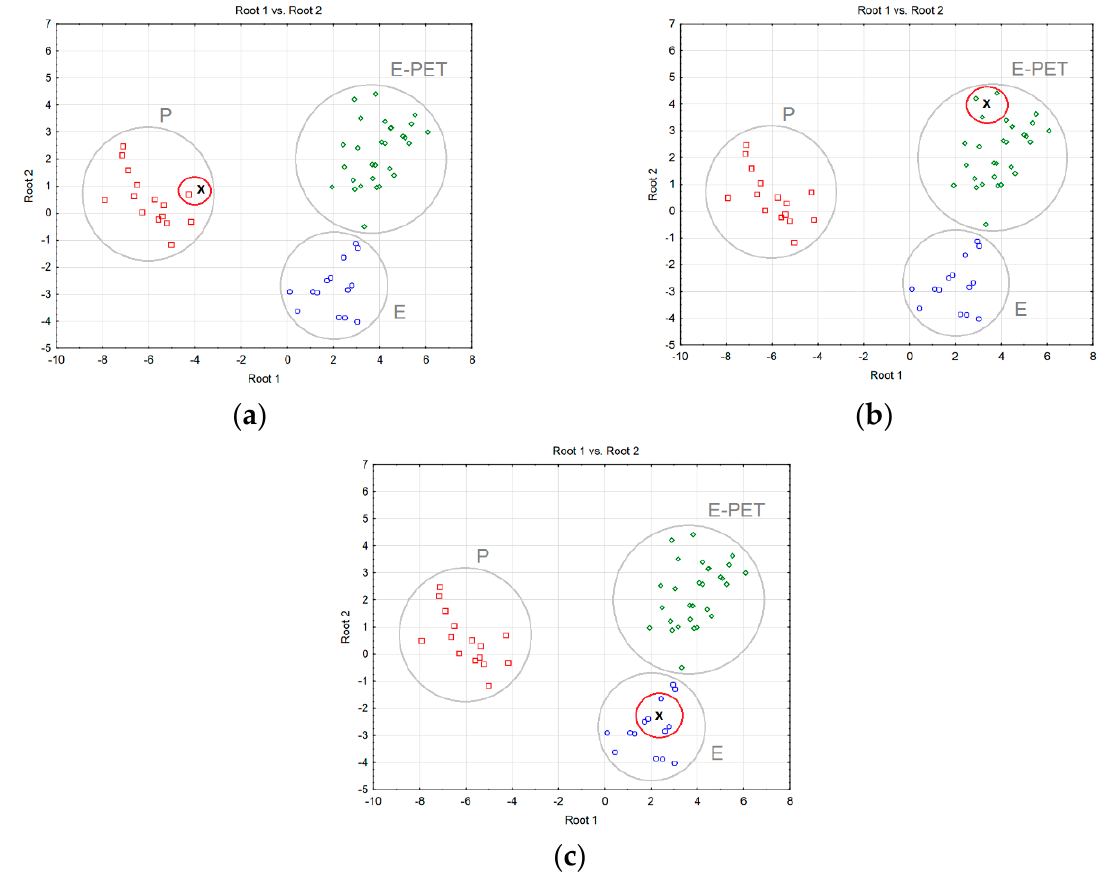
Figure 8. Selection of the mortar composition using the nearest-neighbor method using data from: ( a ) one neighbor, ( b ) three neighbors, ( c ) five neighbors.